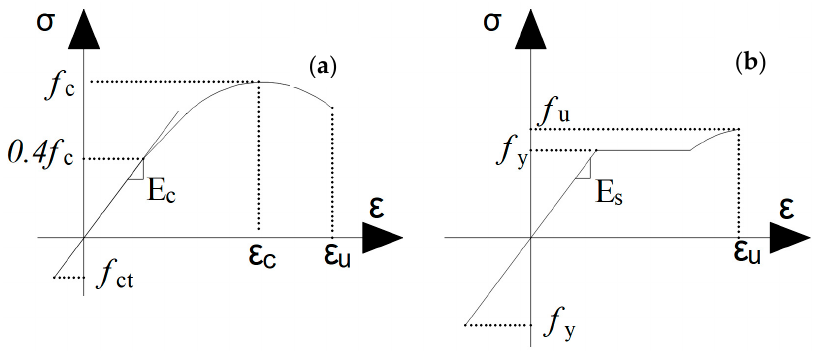
Figure 4. Stress-strain curves for ( a ) concrete and ( b ) steel, both adapted from [21].